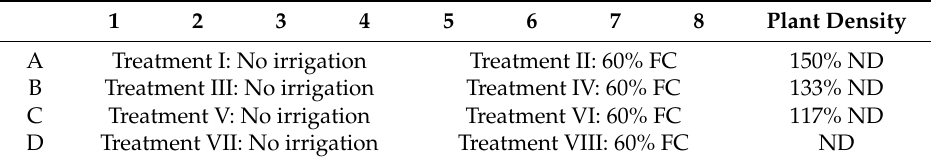
Table 2. Summer maize plot arrangement and irrigation